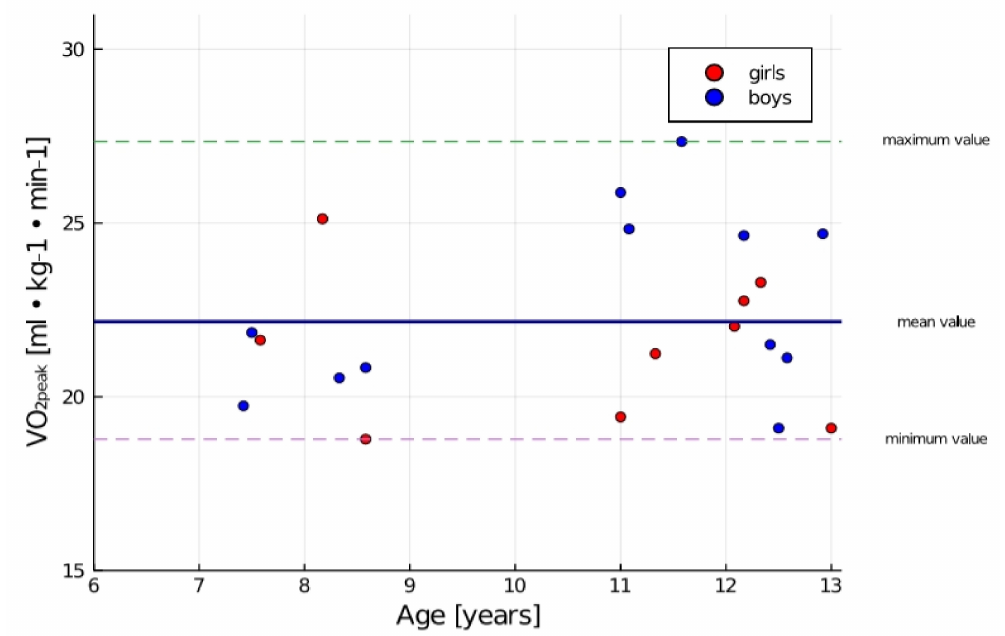
Figure 3. Distribution of measurement results of VO 2peak in the group with the division into sex.